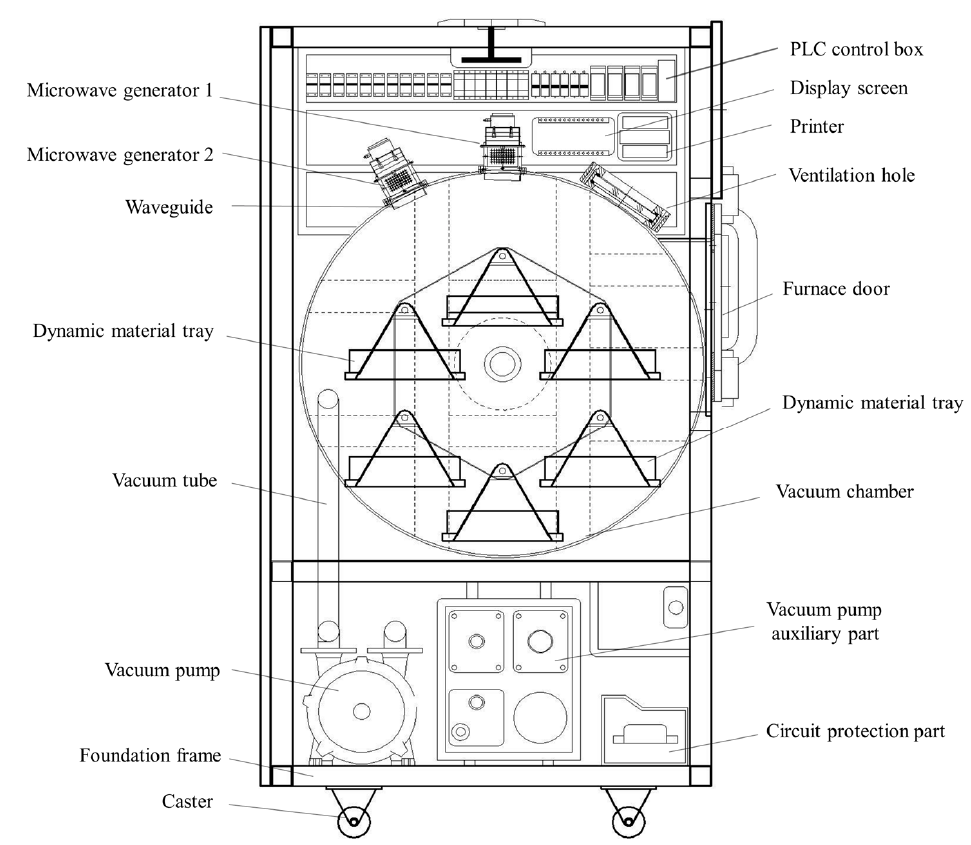
Figure 1. Schematic diagram of the tray rotation microwave vacuum dryer.